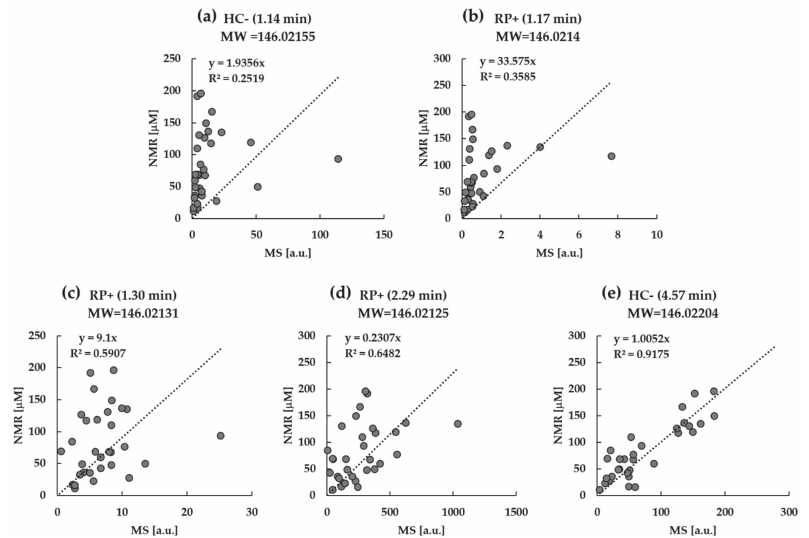
Figure 1. ( a – e ) Correlation plots between the relative MS intensities and 2-oxoglutarate NMR concentrations obtained after the first round for five peaks showing an exact mass compatible with the monoisotopic molecular weight of 2-oxoglutarate (monoisotopic MW =